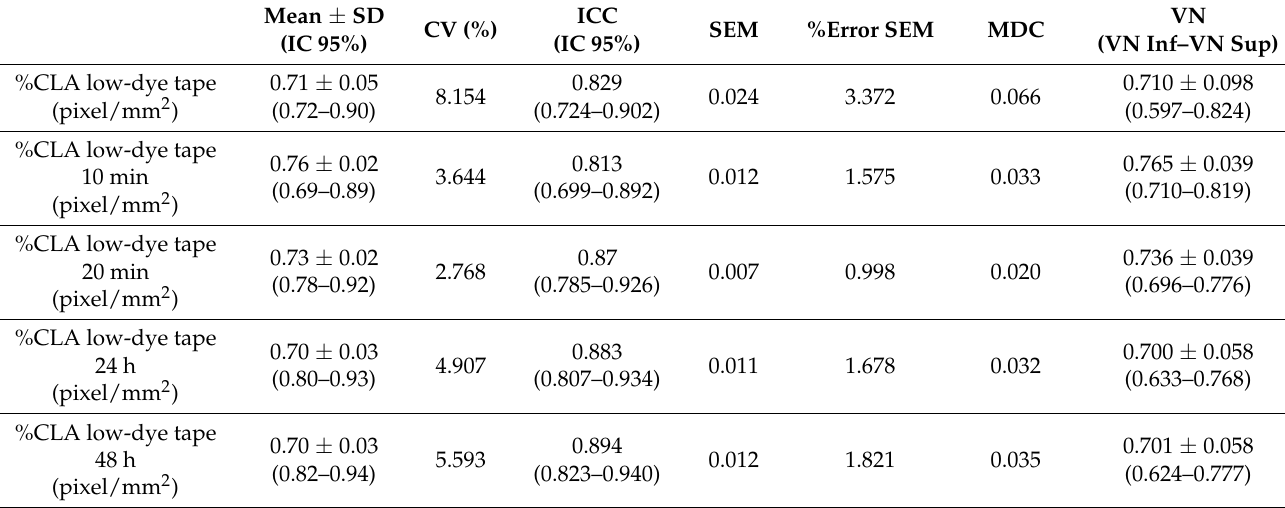
Table 5. Reliability of the percentage of the pressure center in the different times with the taping.